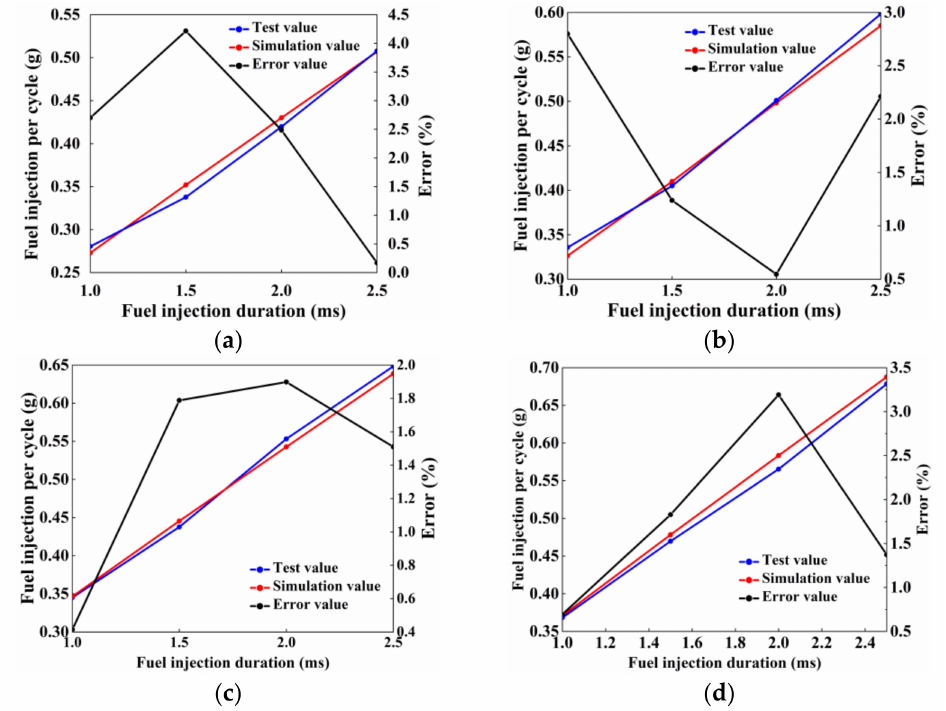
Figure 16. Fuel injection error verification under different rail pressure: ( a ) 80 MPa; ( b ) 100 MPa; ( c ) 120 MPa; ( d ) 140